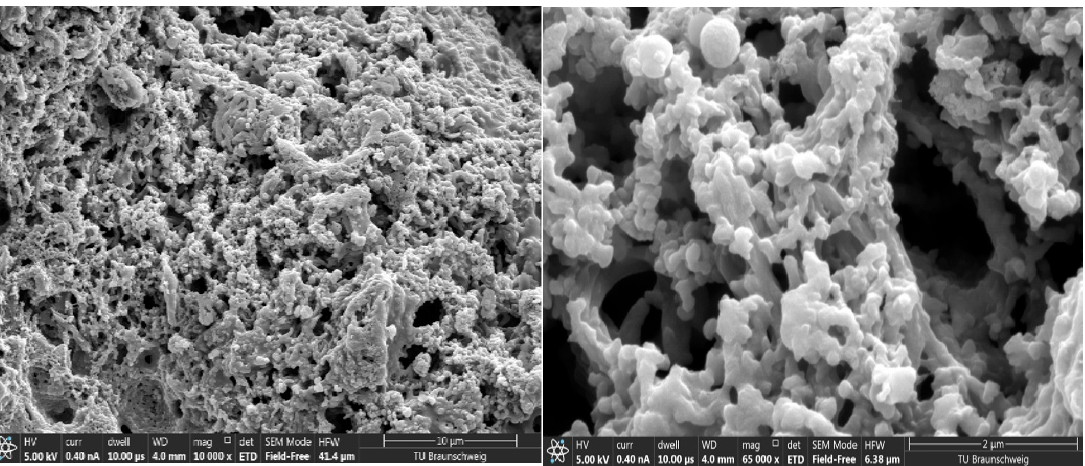
Figure 4. SEM images of PANI–DBSA at a magnification of 10,000 (left) and 65,000 (right) .